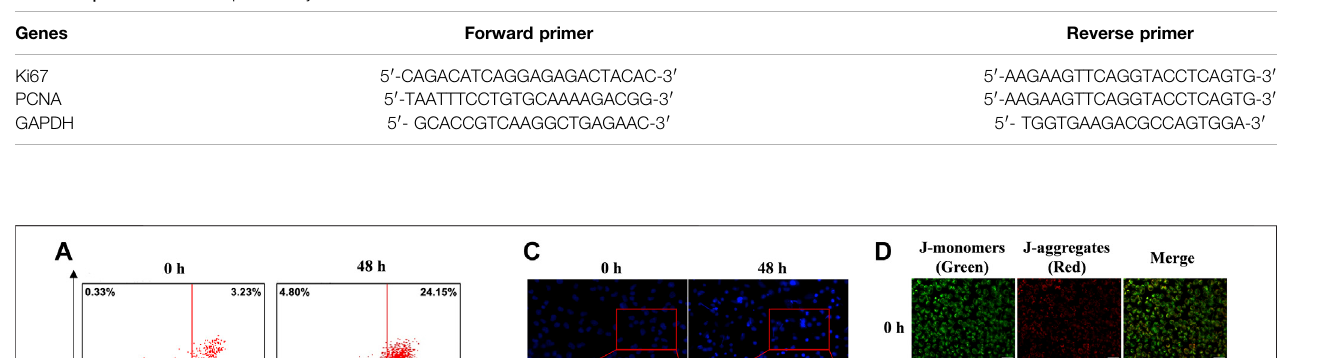
TABLE 1 | Primers used in qPCR analysis.